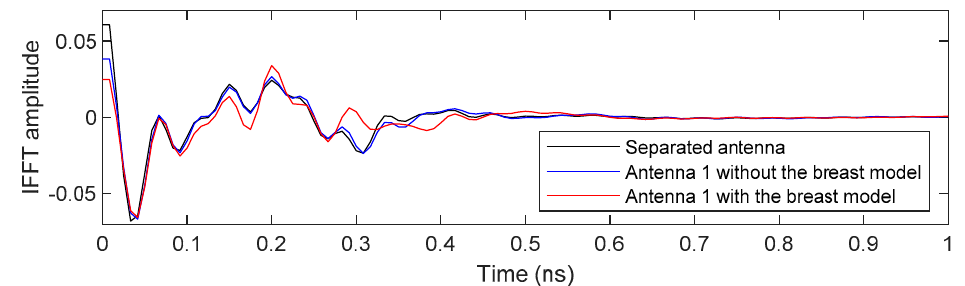
Figure 21. Time domain response of the separated antenna compared to the antenna surrounded by other antennas with and without the breast model.